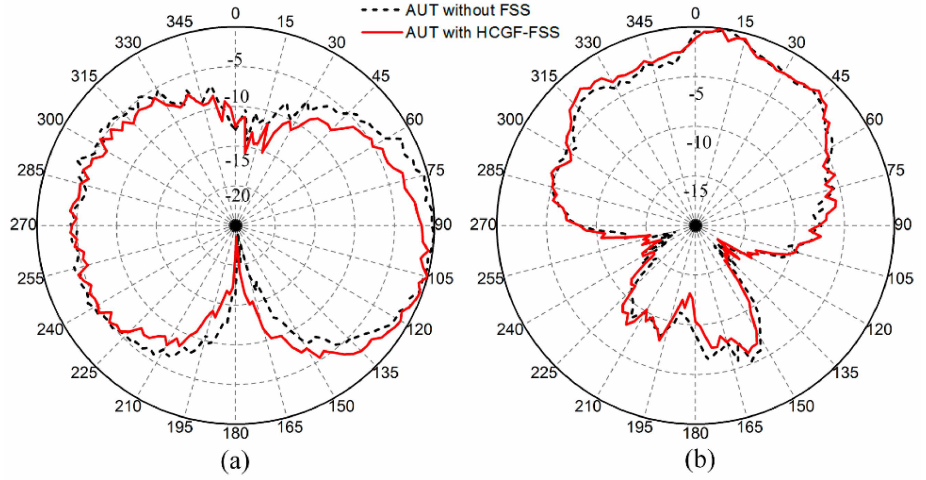
Figure 11. Normalized radiation patterns measured at 3.5 GHz in the x-z plane ( a ) and the y-z plane ( b ).